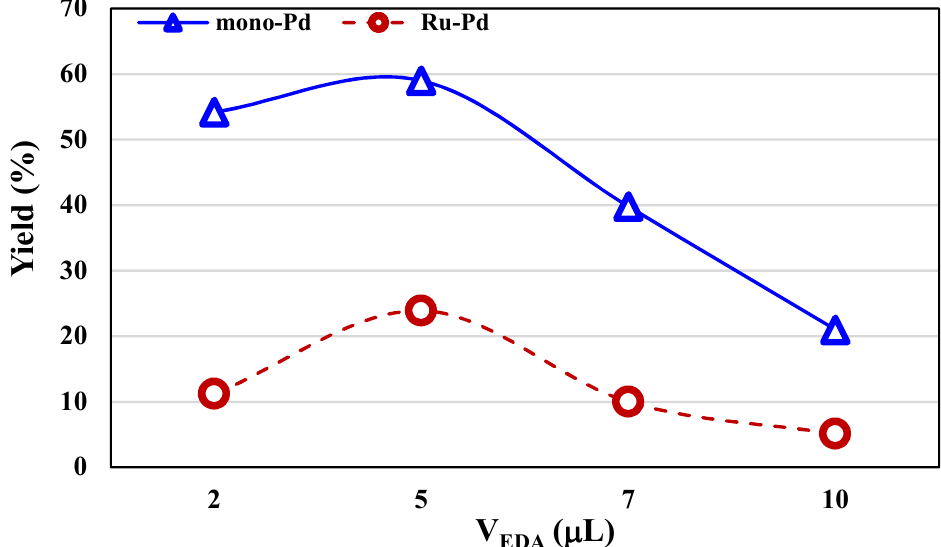
Figure 5. Yield dependence as a function V EDA , at 25 °C, for ROMP of NBE with and Ru/Pd in CHCl 3 for 30 min; [NBE]/[Ru] = 3000.